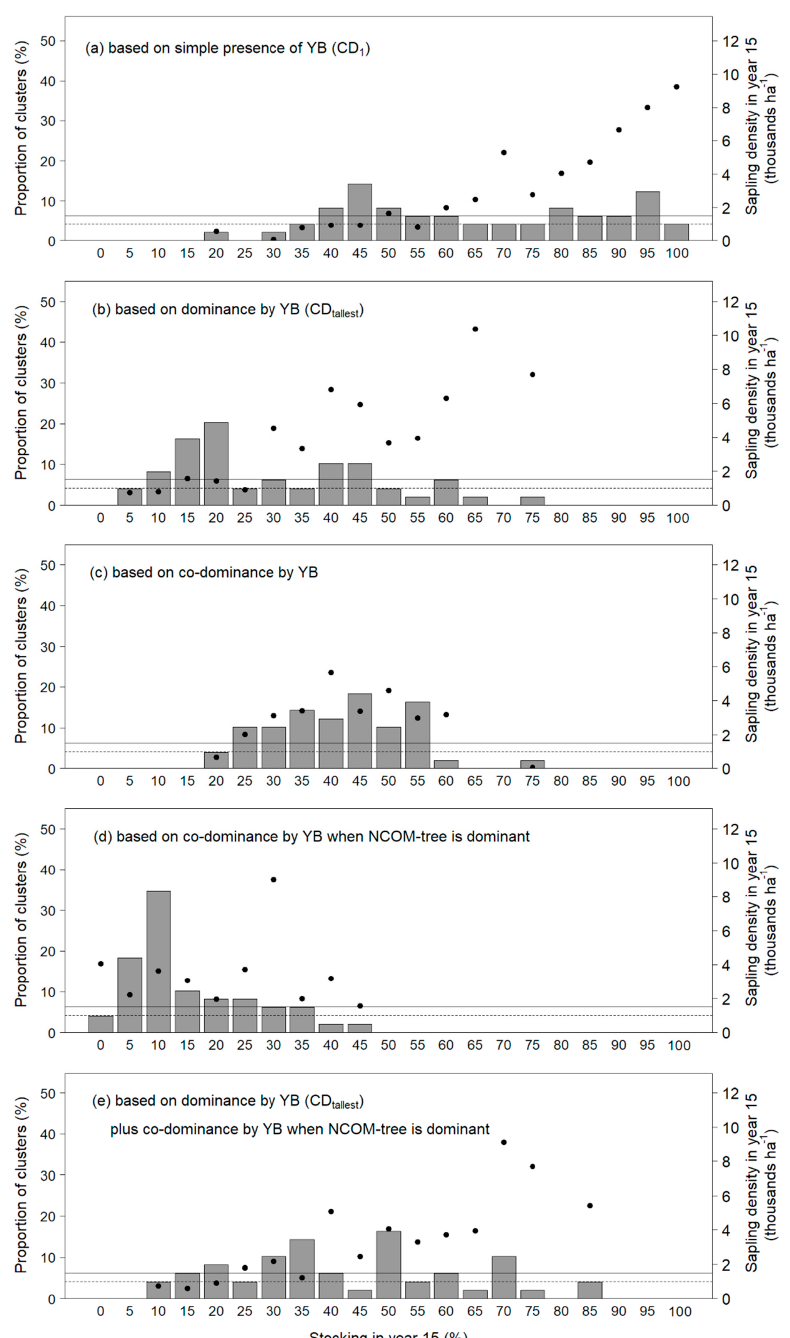
Figure 3. Regeneration stockings for yellow birch (YB), calculated on 6.25-m 2 quadrats and considering all seedlings and saplings, within canopy openings 15 years after harvest. Bars represent the proportion of clusters that show a given 5%-class of stocking. Points are mean sapling densities (all DBH classes) of YB per stocking class. Both stocking and density data are cluster means. Stocking was computed in five different ways: ( a ) based on a single YB stem per quadrat, ( b ) based on YB being the tallest stem in the quadrat, ( c ) based on YB being the second tallest stem in the quadrat regardless of the identity of the tallest stem, ( d ) based on YB being the second tallest stem when a non-commercial tree (NCOM-tree) was the tallest, and ( e ) based on YB being either the tallest stem or the second tallest when NCOM-tree was the tallest, thus a combination of ( b , d ). Horizontal solid and dashed lines represent, respectively, the 1500 and 1000 stems ha − 1 density thresholds proposed by Leak et al. 1987 to assess post-harvest regeneration